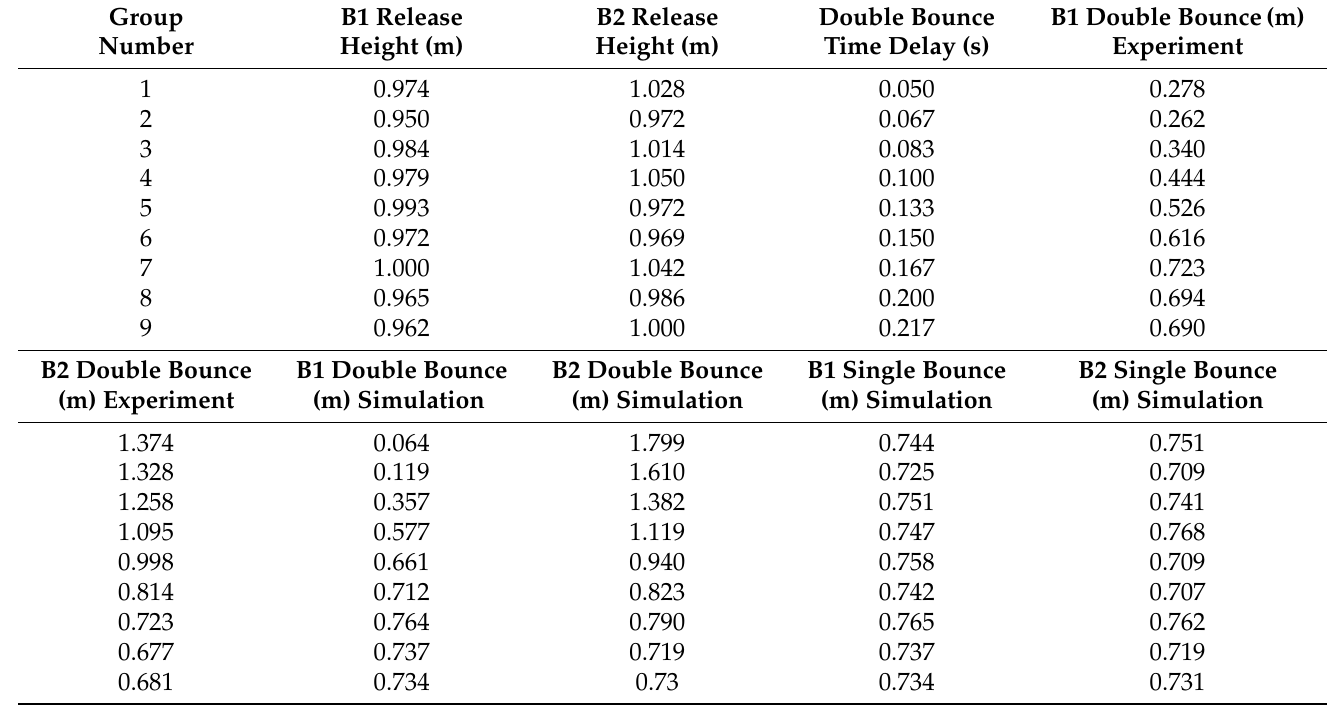
Table 6. Double bounce experiment and simulation results.